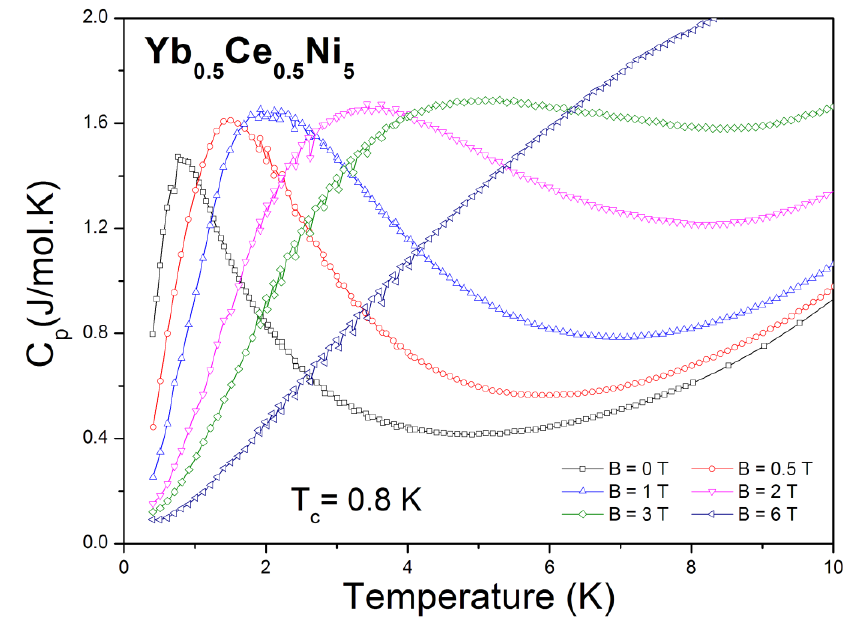
Figure 4. Low-temperature detail of the heat capacity measurement of Yb 0.5 Ce 0.5 Ni 5 compound with a transition temperature of 0.8 K.